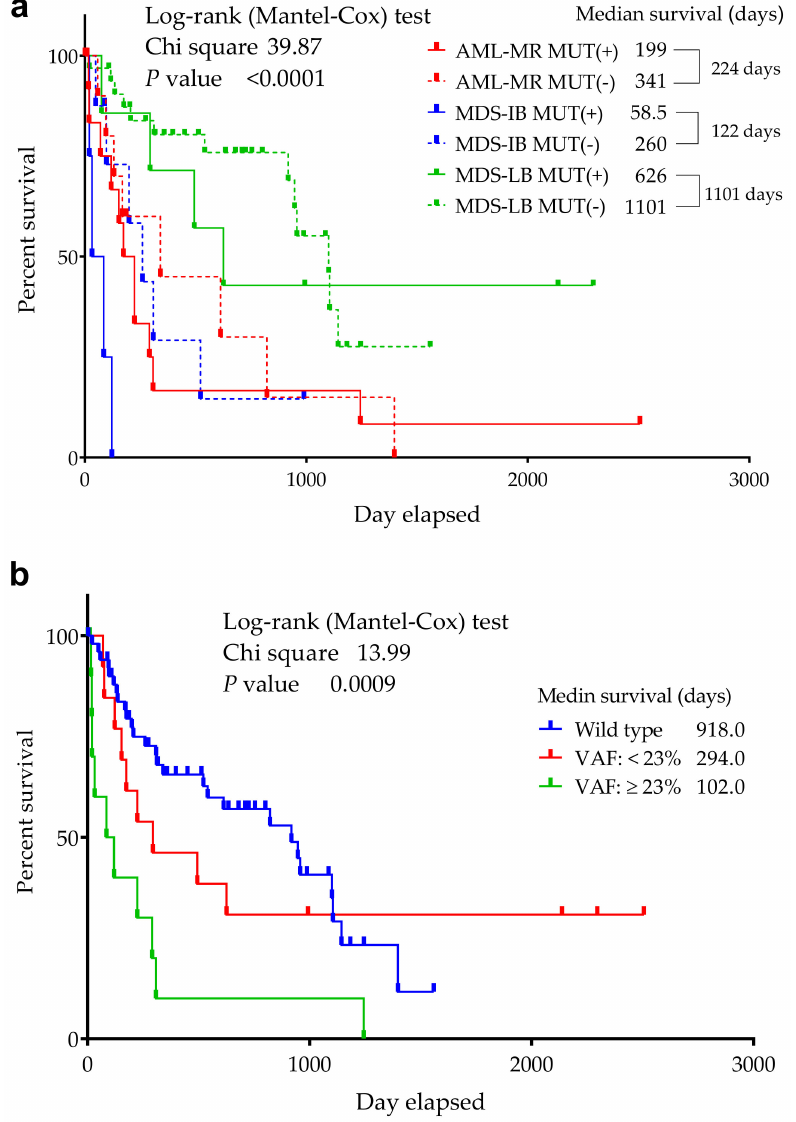
Figure 4. Overall survival of TP53 mutant and non-mutant (wild-type) AML/MDS patients. The abscissa axis shows the survival of the patients in days. The ordinate axis indicates the group’s remaining survivals (%) of all group members. ( a ): Patients are divided into six groups according to mutation status and diagnosis. ( b ): Patients are divided according to VAF distribution. A VAF > 23% had an increased risk of death compared to wild-type patients, while cases with a VAF ≤ 23% had a similar OS to wild-type patients